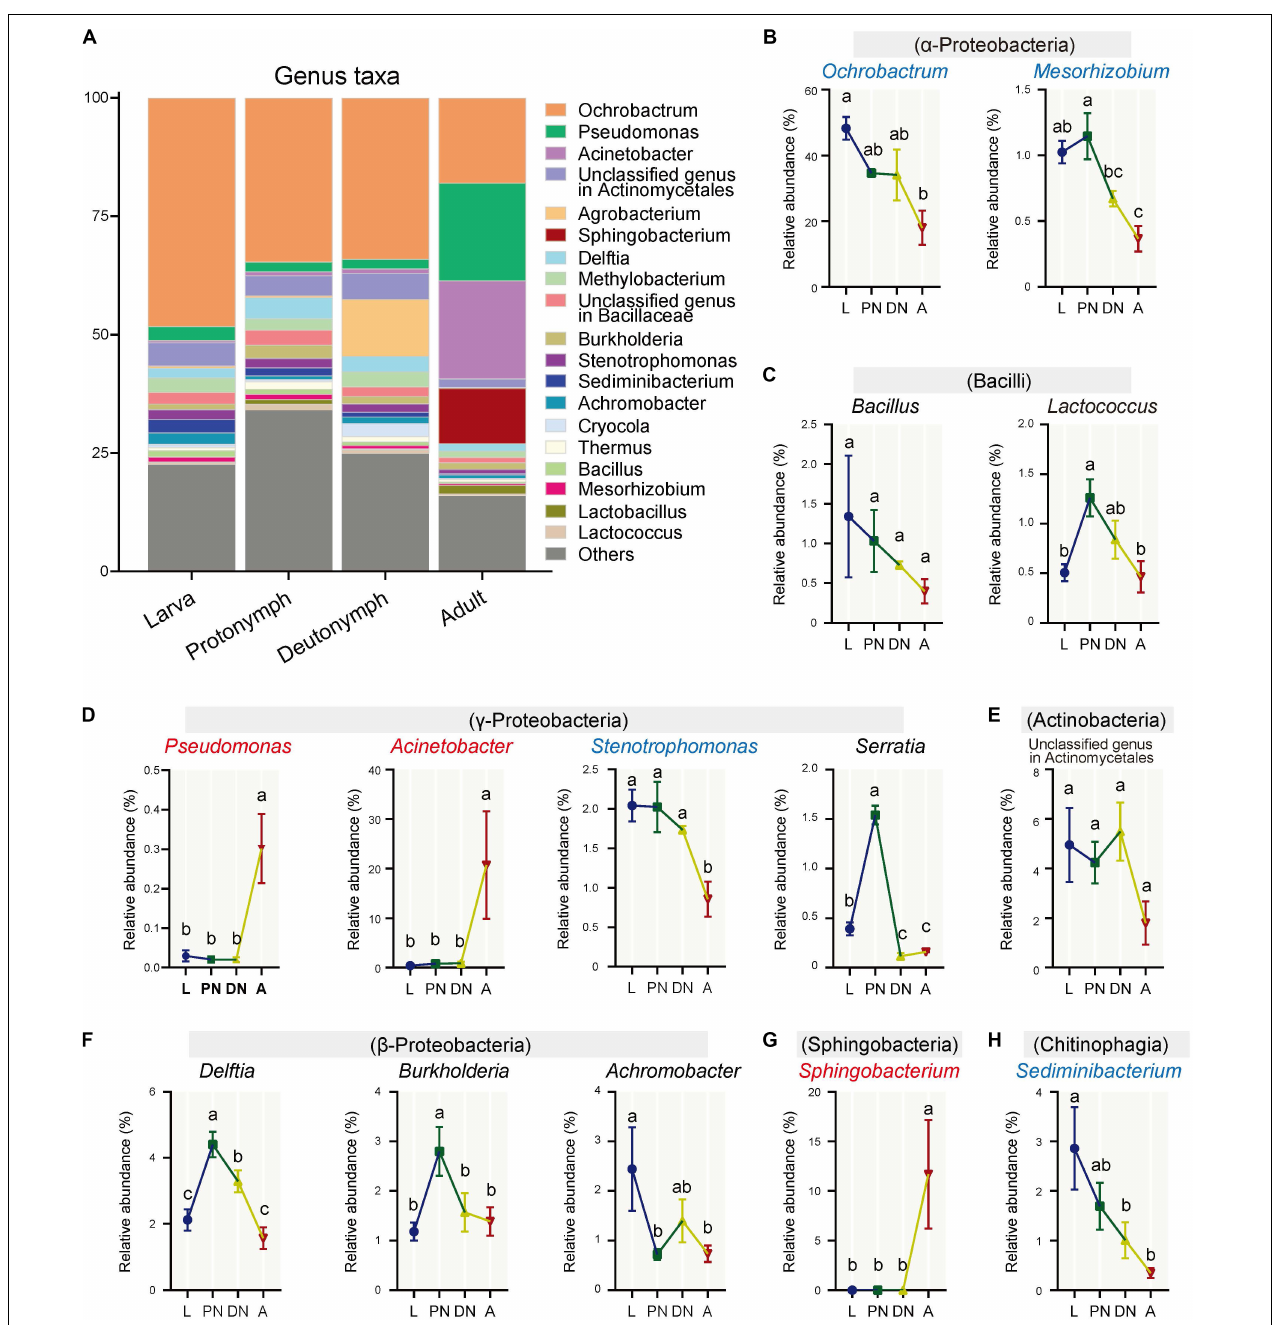
FIGURE 3 | Variations of the relative abundances of bacterial genera across the lifespan of P. citri . (A) Whole profiles of the relative abundances of the genera in each life stage; only taxa with a relative abundance > 1% in at least one sample were analyzed. (B–H) Comparisons of the relative abundances of 14 major genera across the larva (L), protonymph (PN), deutonymph (DN), and adult (A) stages; all n = 3; different lowercase letters denote significant differences between different life stages ( P < 0.05, post hoc DMRT); the genus names in red or blue color indicated the relative abundances of corresponding genera significantly increased or decreased in the adult stage, respectively; the corresponding classes were presented in parentheses; plots showed means ±